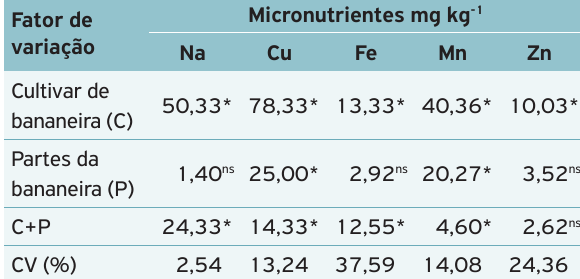
Tabela 1. Valores F obtidos na análise de variância de micronutrientes nos subtratos iniciais à base de resíduos (pseudocaule, folha e pseudocaule + folha) de quatro cultivares de bananeira (Thap maeo, Prata anã, Pelipita e Caipira).